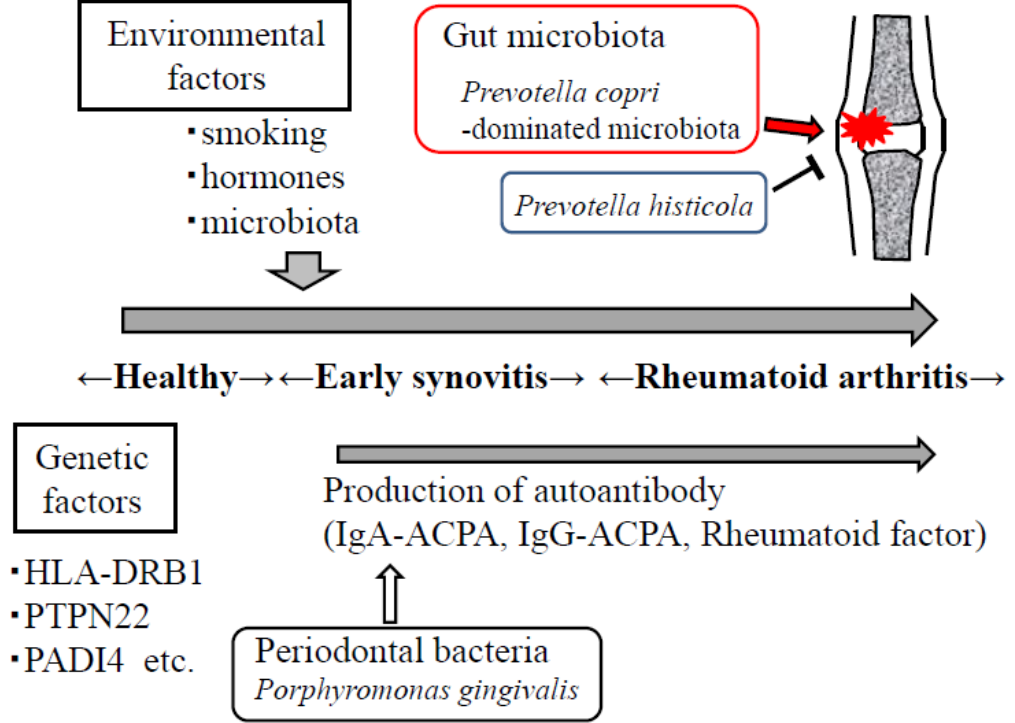
Figure 1. Environmental factors such as smoking, hormones, gut microbiota, and periodontal bacteria are important in the development of rheumatoid arthritis. Prevotella copri -dominated microbiota may contribute to the development of arthritis, whereas P. histicola suppresses the onset of arthritis.